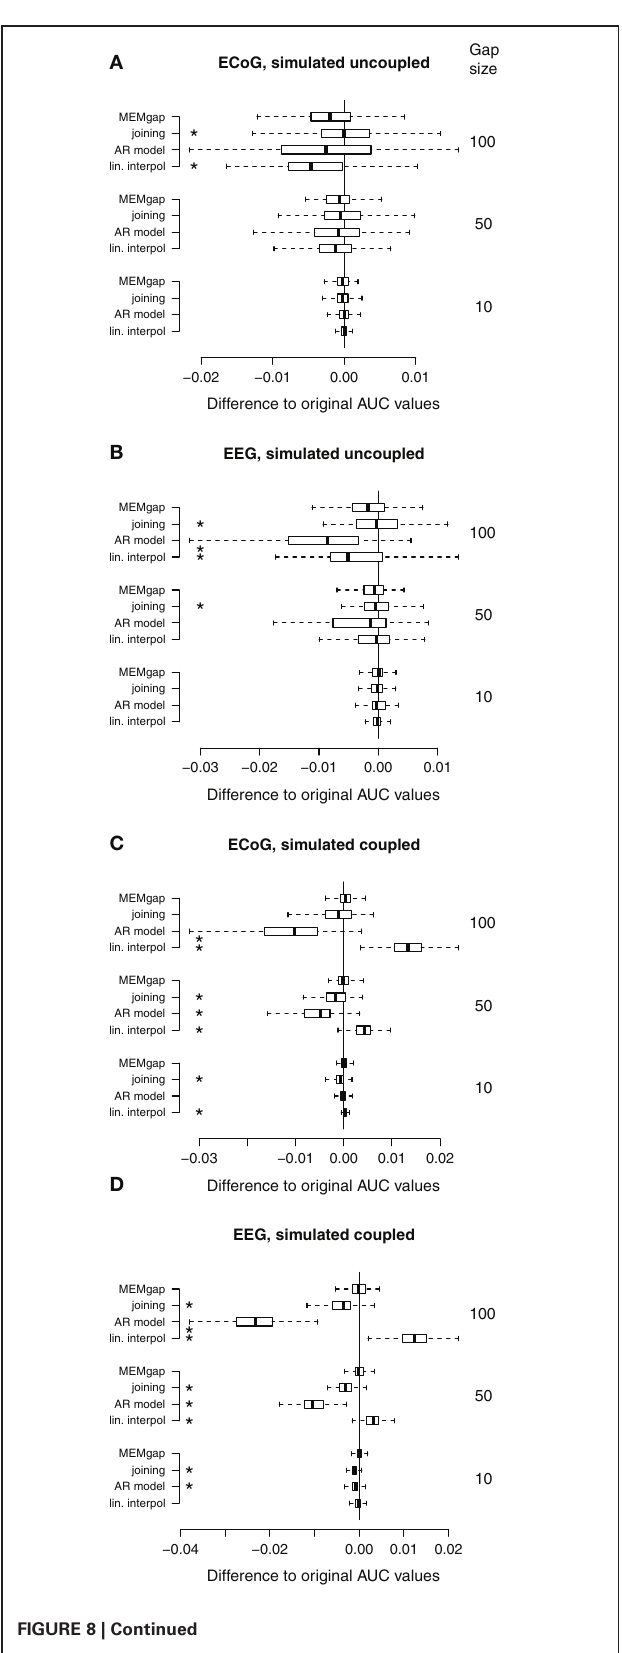
FIGURE 8 | Distributions of the differences between AUC values without gaps and AUC values of gap sizes of 10, 50, and 100 for data sets without stimulation. A deviation from 0 indicates an over- or under-estimation of class separability. (A) ECoG and (B) EEG data with gaps simulated throughout the whole trial ( uncoupled condition). (C,D) AUC values computed on the same data sets as in (A) and (B) , respectively, but with gaps simulated only within the movement phase ( coupled condition, BSDS). Boxes cover the range between the lower and upper quartile of AUC differences with the median depicted as a black line. The whiskers extend to the most extreme data point which is no more than 1.5 times the interquartile range away from the box. ∗ AUC scores differ significantly from MEMgap for this gap size ( p < 0 . 05, Friedman test,